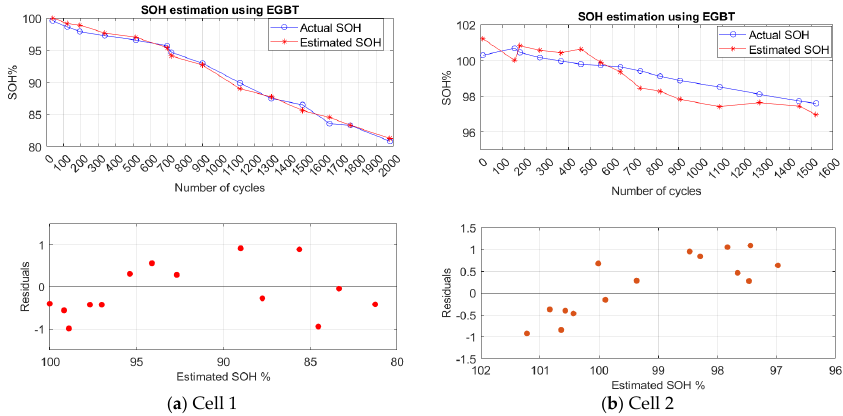
Figure 8. State of health ( SoH) estimation results of ( a ) Cell One and ( b ) Cell Three based on ensemble gradient boosted tree (EGBT) model.